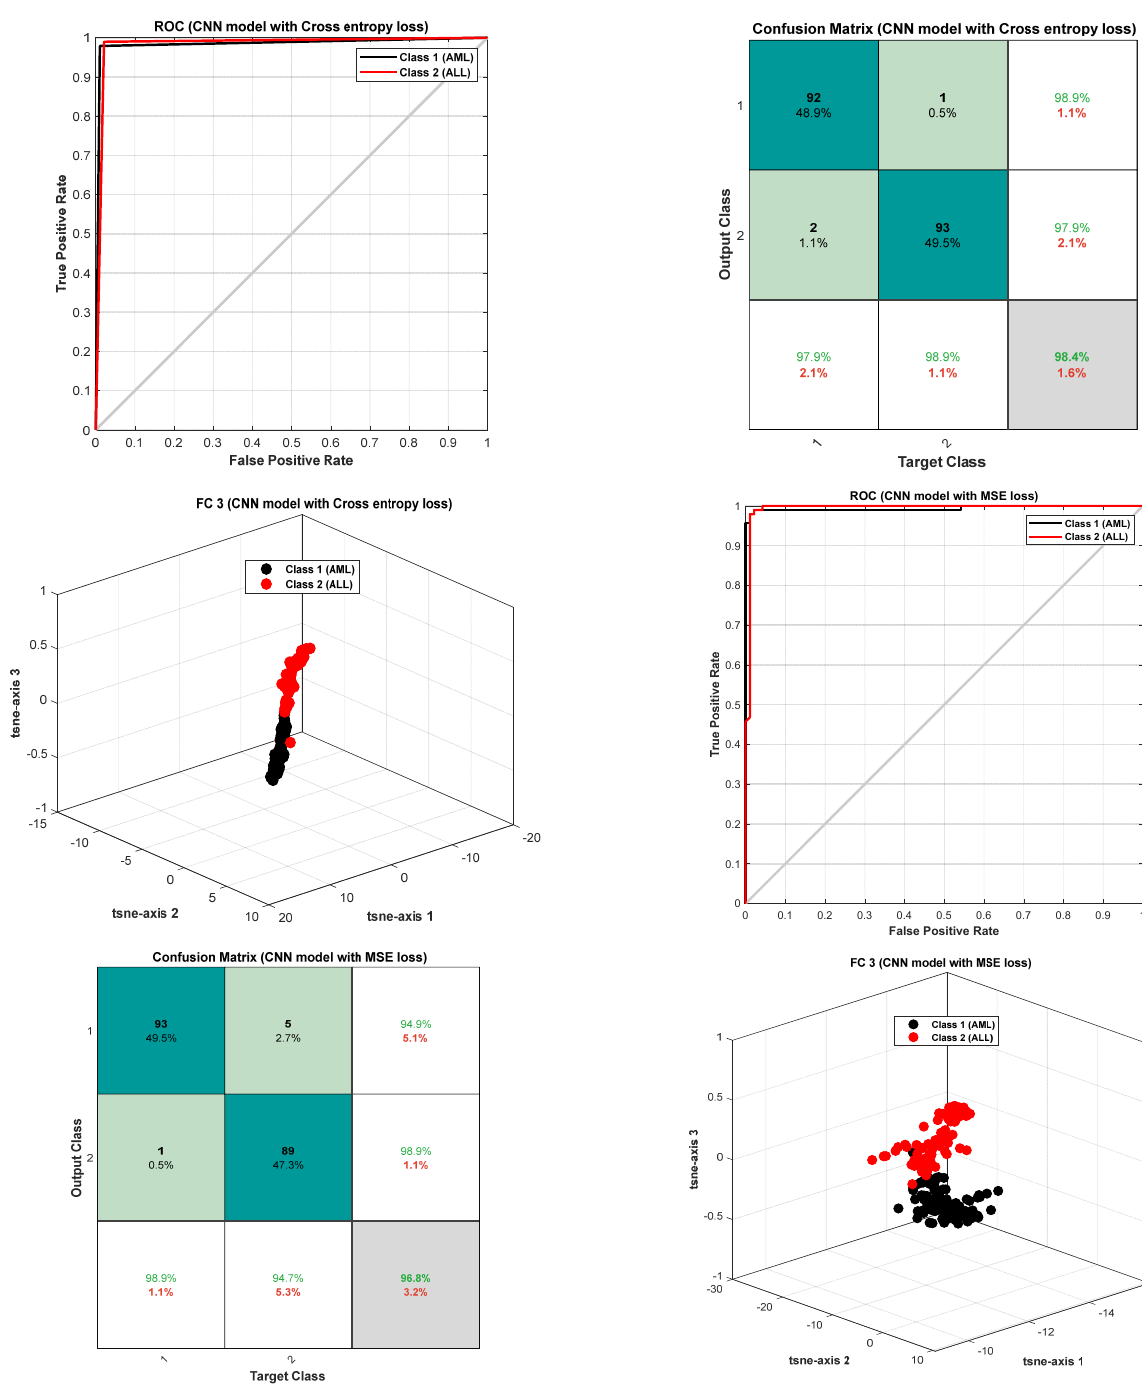
Figure 13. The confusion matrices and ROC plots for the CNN model with the cross-entropy and MSE loss functions based on test data.